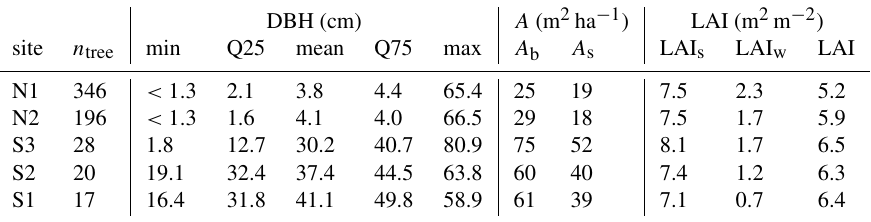
Table 5. Observed biometric characteristics of the five forested sites along the transect. Column names: n tree ...number of trees with circumference > 4cm in a 20 by 20m reference plot, diameter at breast height (DBH) distribution with minimum, first quartile, mean, third quartile, and maximum (cm), total stand basal area A b (m 2 ha − 1 ), total stand sapwood area estimated from published allometric